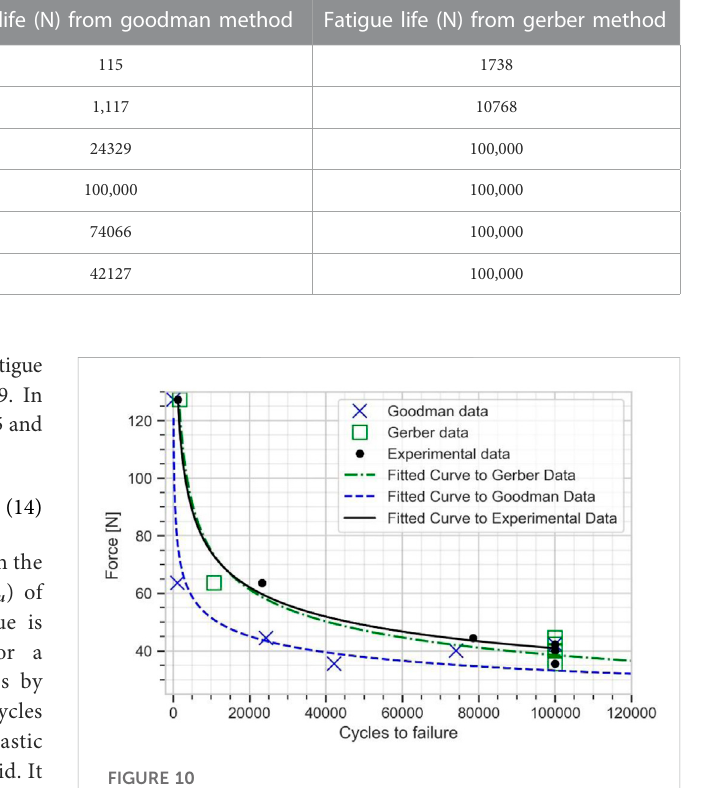
FIGURE 10 Force vs. number of cycles to failure curve for the plate from experimental data, Goodman, and Gerber mean stress correction using elasto-plastic FE